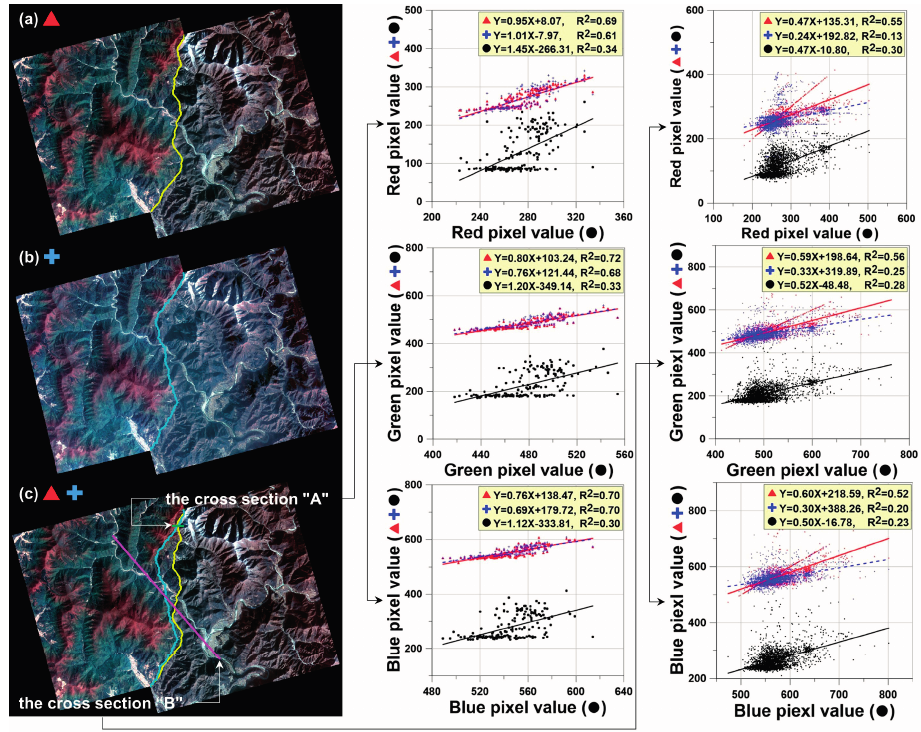
Figure 10. Comparisons between ( a ) the proposed and ( b ) previous algorithms. The red triangles denote the mosaic image by the proposed method, while the blue crosses indicate the mosaic image by the previous method. The black circles present the input image data. The yellow and blue lines in ( a , b ) show the seamlines from the proposed and previous methods, respectively. The graphs in the center and right lines are each generated from the cross-sections A and B of ( c